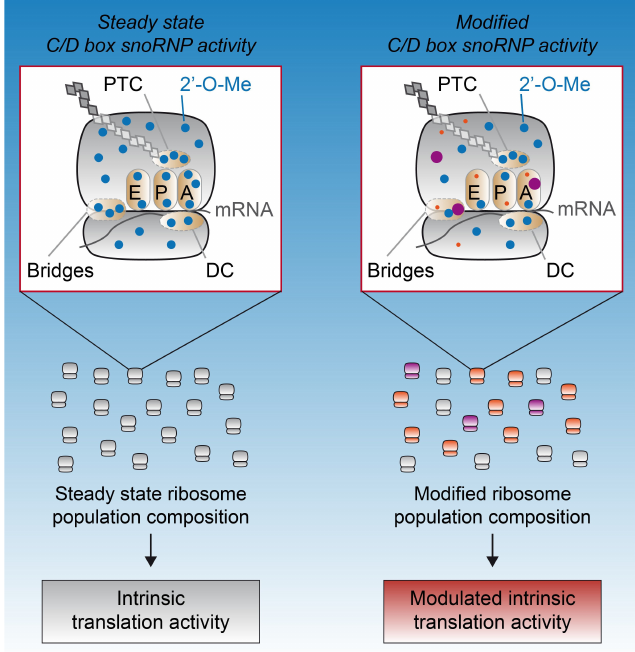
Figure 2. Model of 2 (cid:48) -O-methylation (2 (cid:48) -O-Me) profile modulation and its consequence on the intrinsic translational activity of ribosomes. In this model, we represent two possible states: a steady state